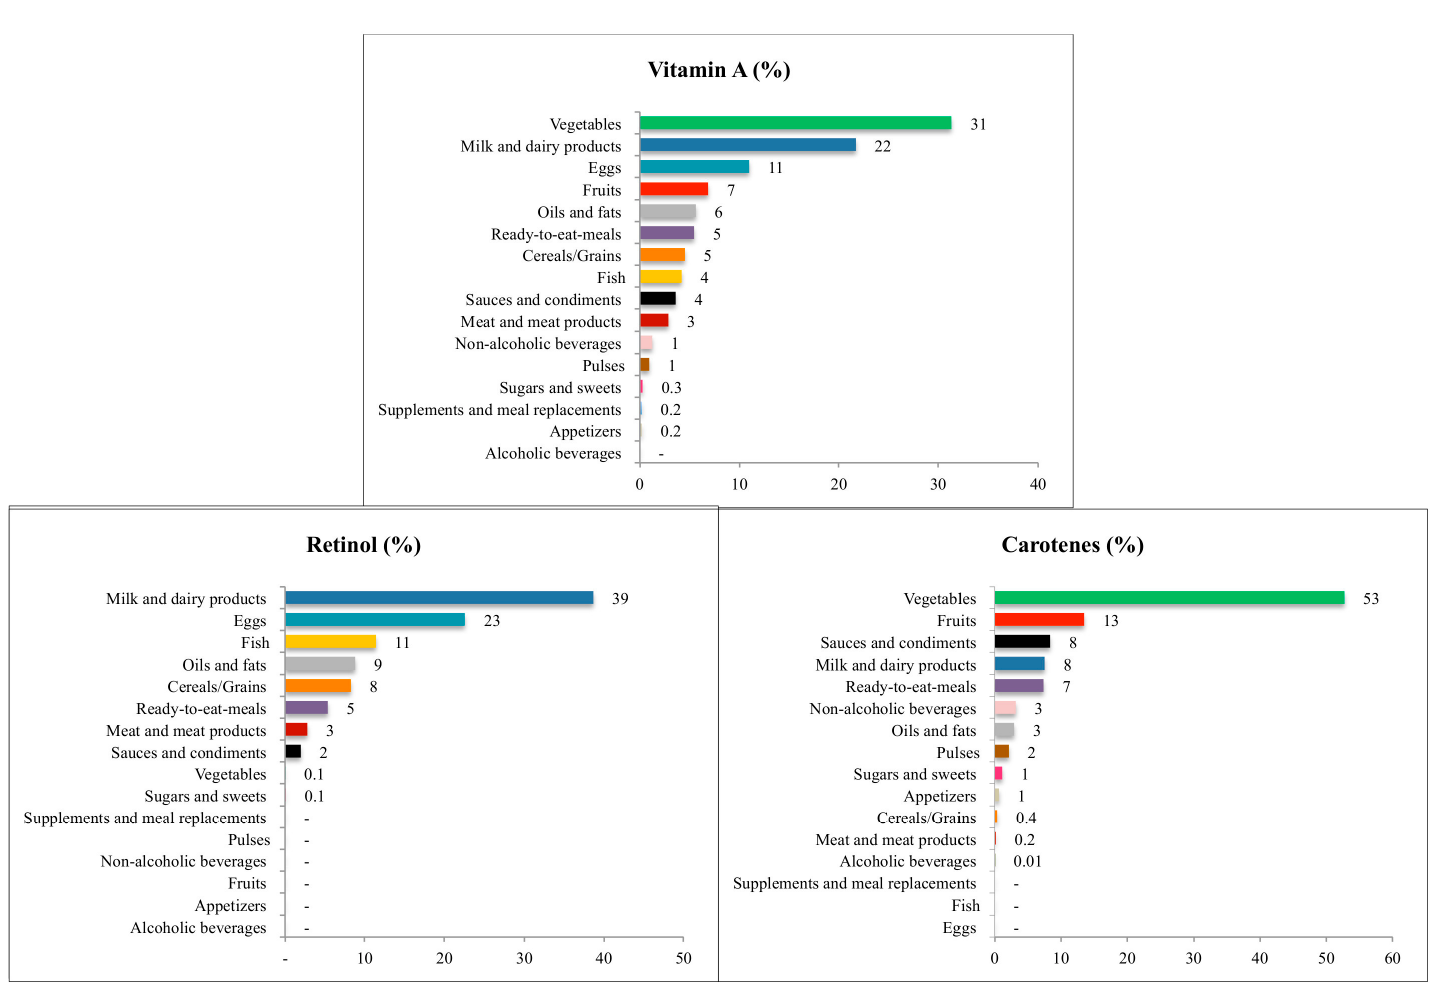
Figure 2. Contribution of food sources to the daily zinc, selenium, and vitamins E and C intake in the ANIBES Study population.